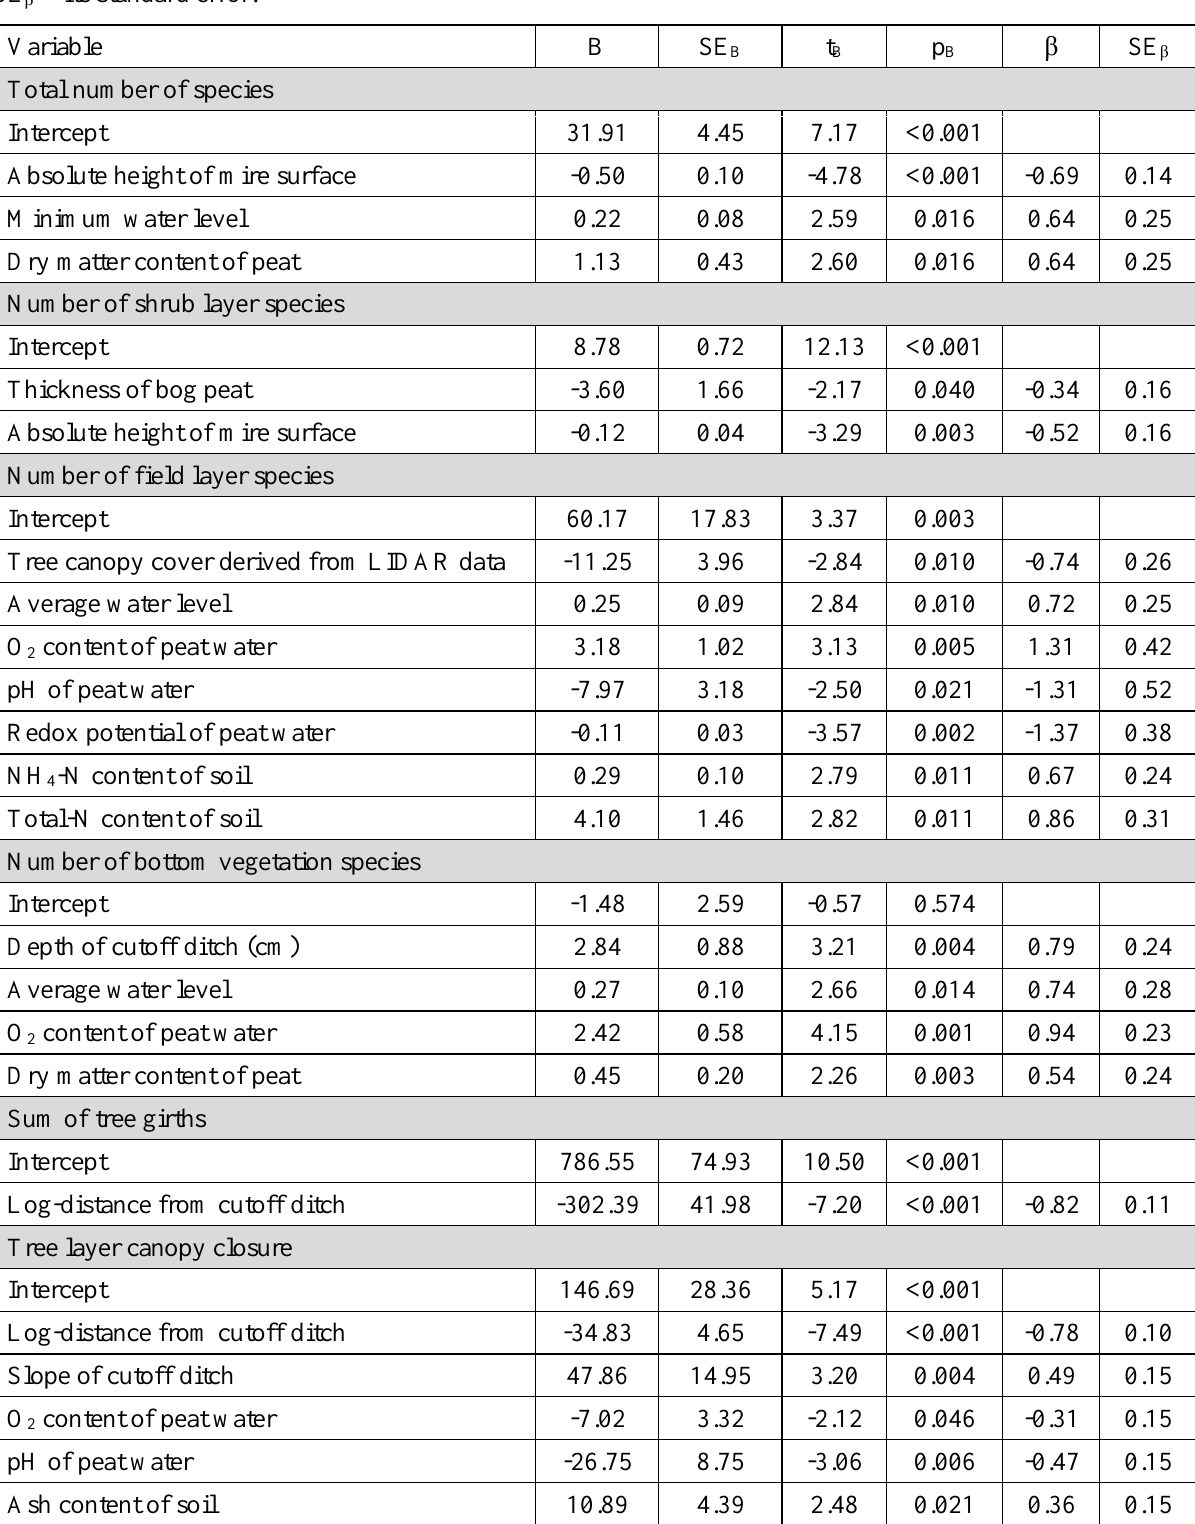
Table A1. Environmental factors affecting vegetation structure according to the multiple regression analyses by stepwise backward removal of variables. Notations: B = non-standardised regression coefficient (slope); SE B = its standard error; t = value of t-criterion; p = significance level; β = standardised regression coefficient; SE β = its standard